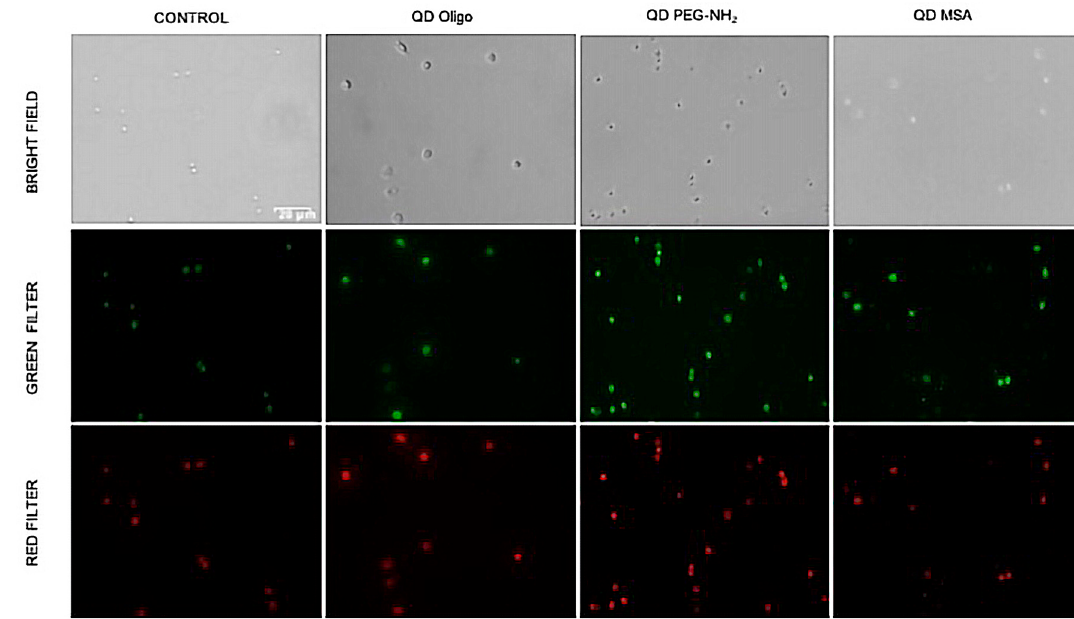
Figure 5. Profiling of ROS formation by fluorescence microscopy was achieved in RAW 264.7 cells loaded with ROS/Superoxide detection reagents and treated with QDs (Oligo, PEG-NH 2 , and MSA). Control (untreated) samples indicate low green and red fluorescence upon induction. General oxidative stress levels were monitored in the green channel, while superoxide production was detected in the red channel. Scale bar: 20 μ m.